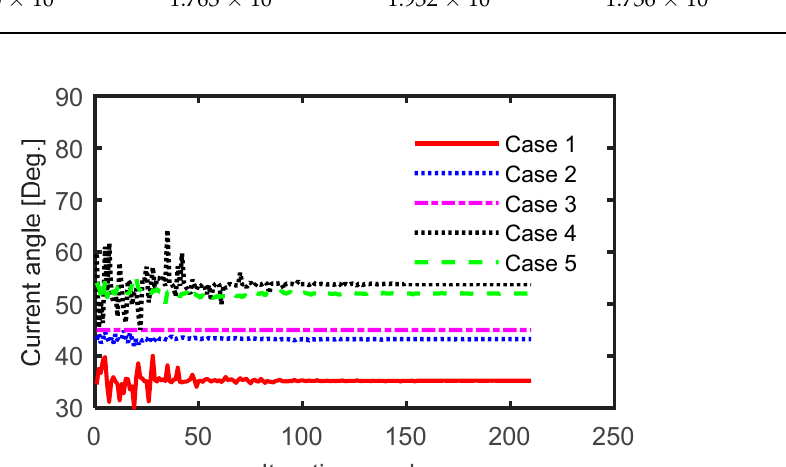
Figure 3. Variation of current angle versus iteration number for different cases.